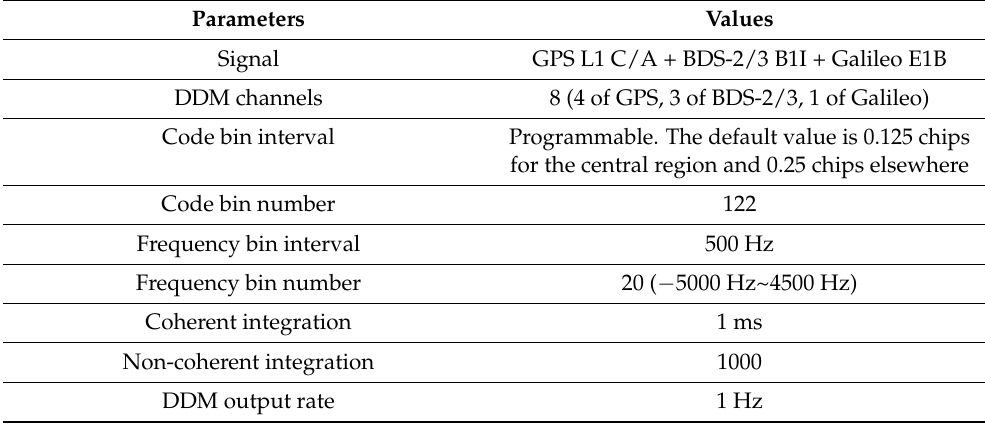
Table 3. Parameters of the GNSS-R module of the GNOS-II onboard the FY-3E satellite.